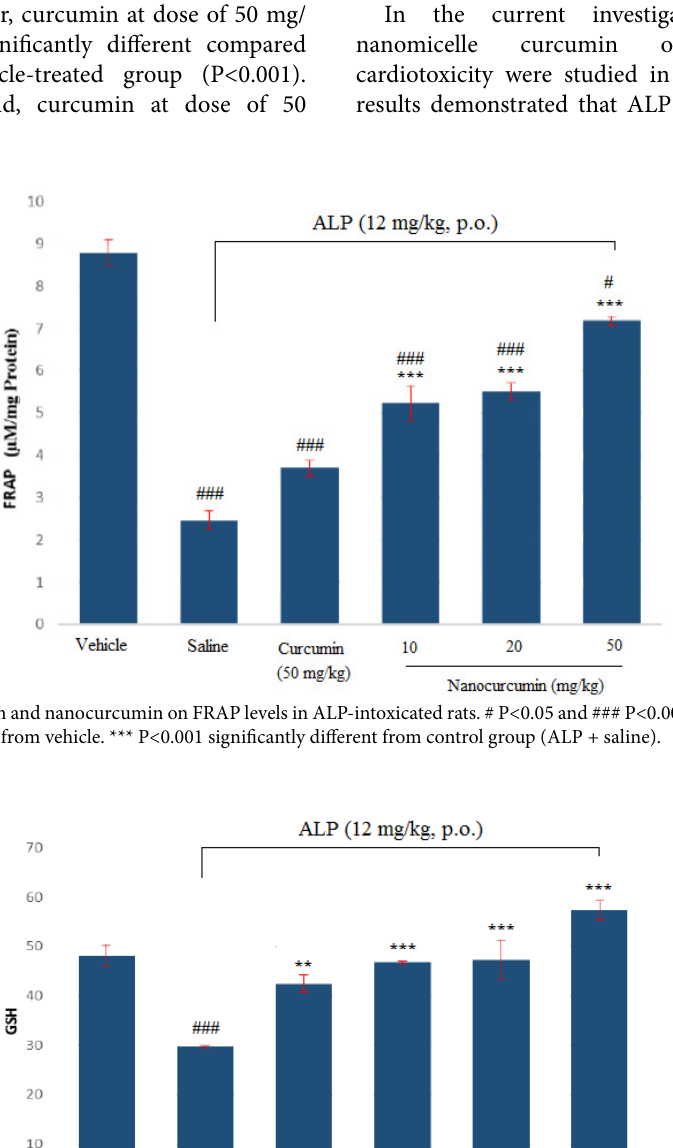
117 Nanomed Res J 4(2): 111-121, Spring